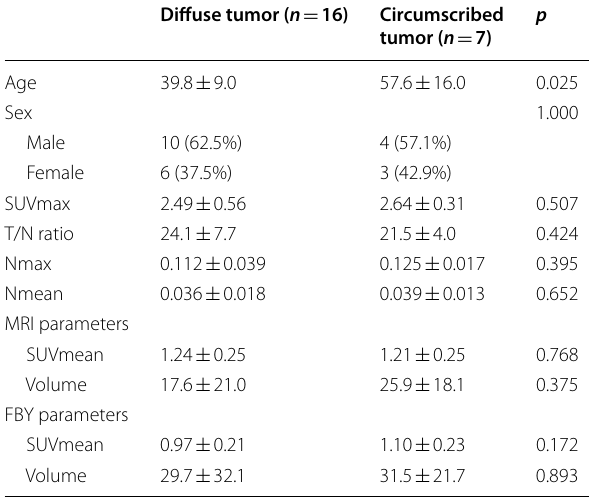
Table 1 Baseline and metabolic characteristics of the included patients